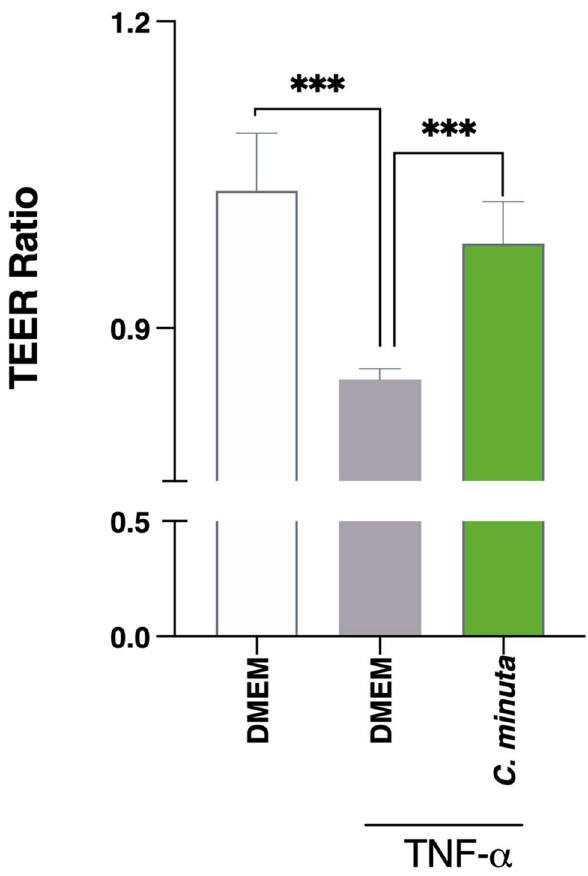
Figure 3. Effects of Christensenella minuta on intestinal barrier permeability. Polarized monolayers of Caco-2 cells were exposed to TNF-α to disrupt the intestinal barrier. TEER was measured immediately prior to and 24 h after TNF-α exposure. Results of Mann Whitney U tests comparing the DMEM + TNF-α group to the other groups: *p < 0.05, **p < 0.01, and ***p <